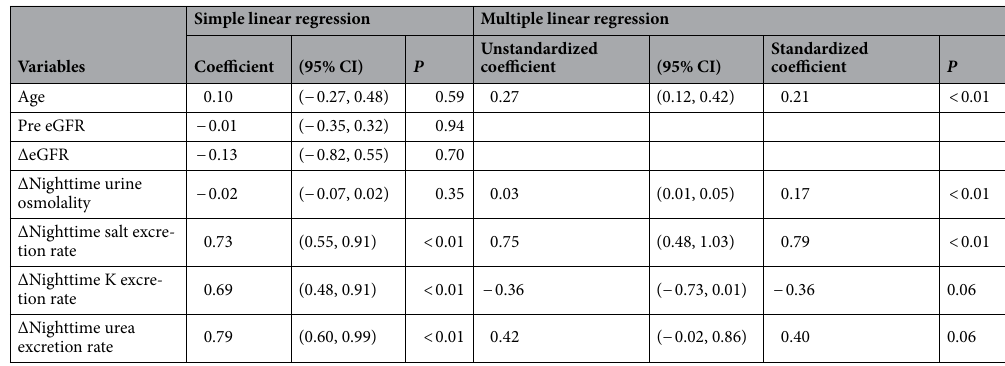
Table 2. Factors associated with the increase in the nighttime urine volume rate. Pre Preoperative, eGFR estimated glomerular filtration rate.